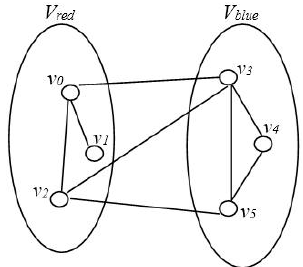
Figure 1. An instance of undirected graph G .